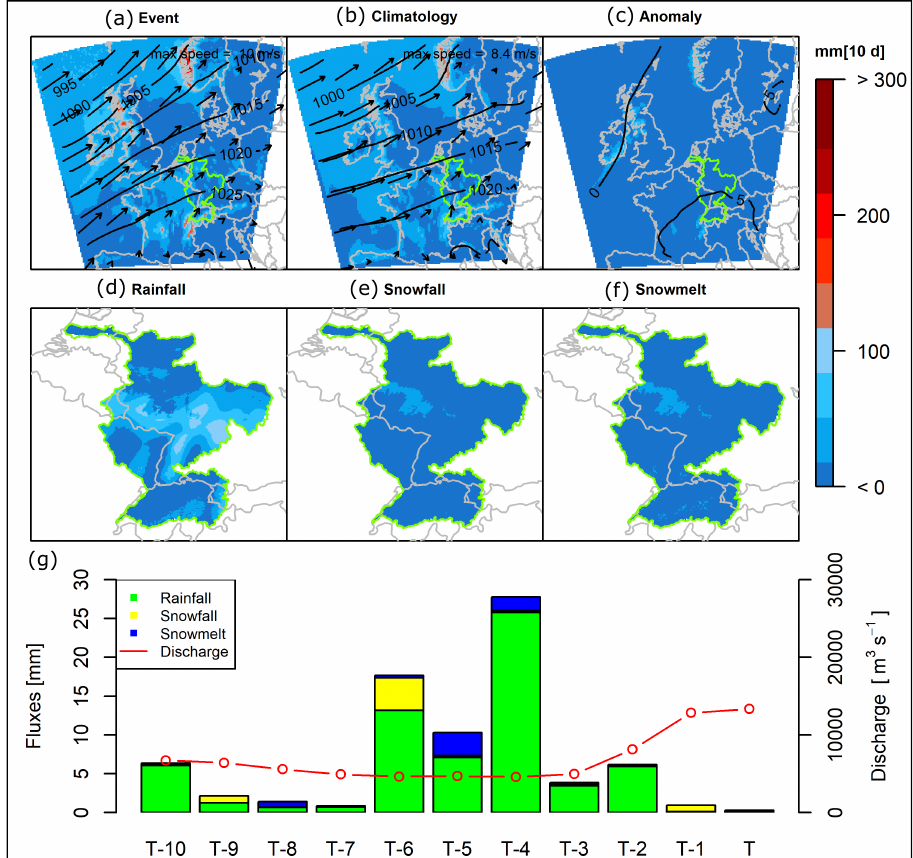
Figure 10. As for Figure 9, for the most extreme event in the one-day block shuffled simulation (date: 1982-01-15; member